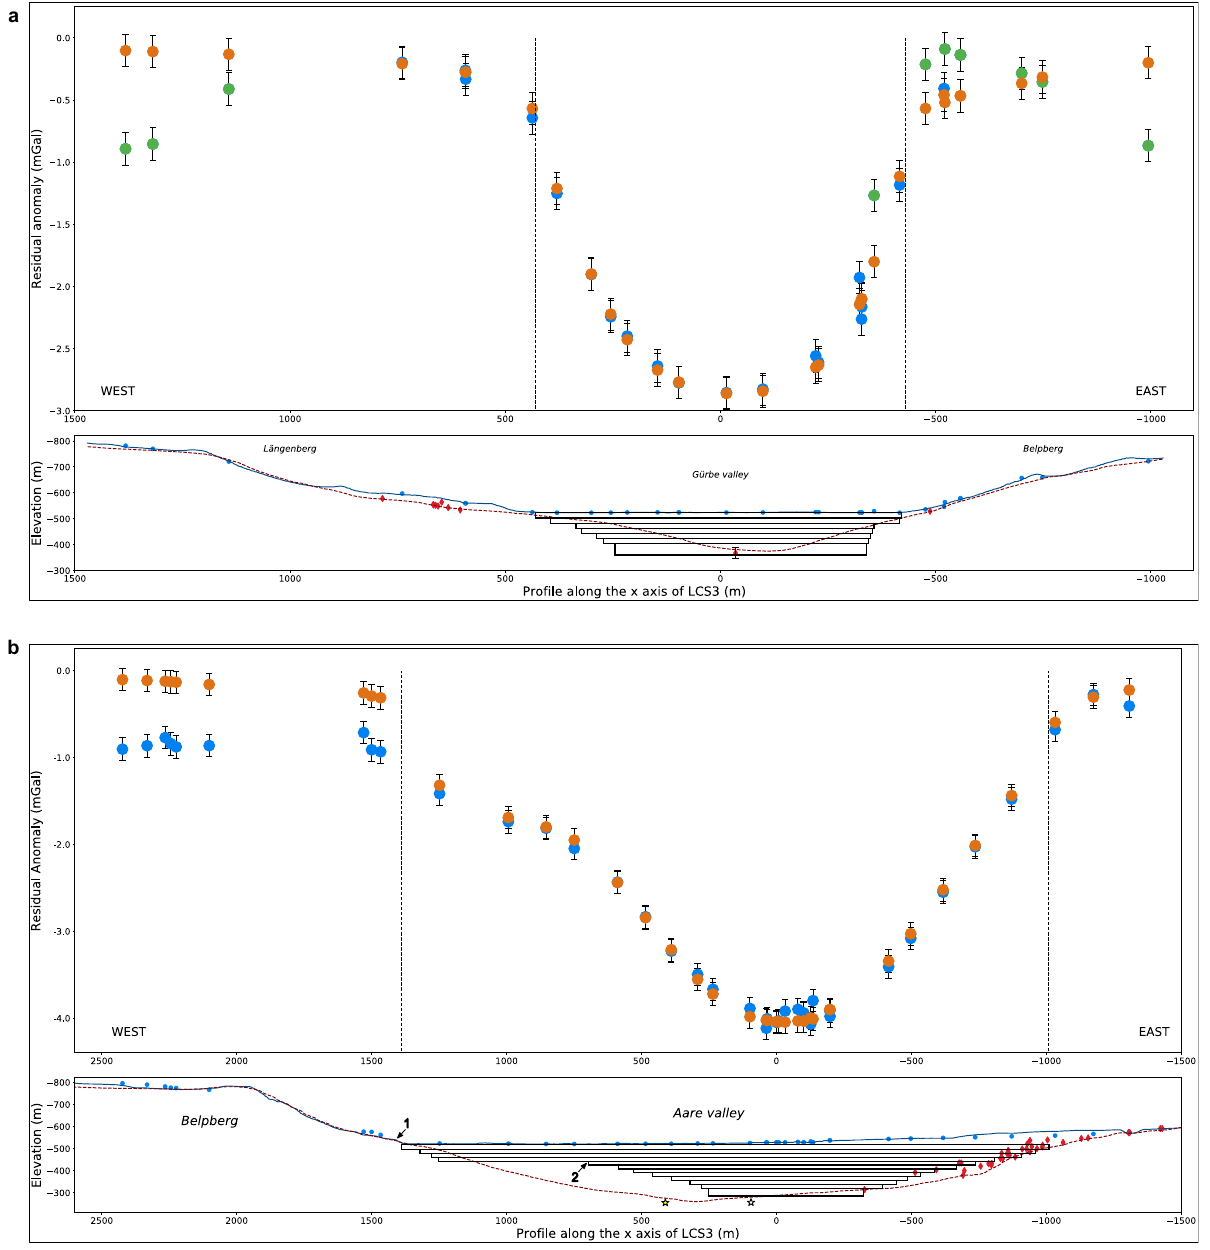
Figure 5. Results of gravity modelling. ( a ) Top: Final modelled residual anomaly, shown by the orange dots. Bottom: Plot of the final geometry of the Gürbe valley. This model suggests that the Gürbe valley is underlain by an overdeepening with an asymmetrical, U-shaped geometry. At our section, we estimate a maximum depth of c. 160 m. The eastern valley flank displays a knickzone at c. 40 m depth, which corresponds to the elevation where an LGM till has been encountered in the drilling RB9201 (Fig. 6b). ( b ) Similar plot for the Aare valley overdeepening, characterized by a maximum depth of c. 235 m. The western flank indicates the presence of two steps marked by the numbers 1 and 2 in the Figure. On the eastern margin, the bedrock flanks dips at c. 20°. The valley bottom has approximately the same cross-sectional width as the Gürbe overdeepening. Note that the drillings on the eastern margin imply a complex geometry as the bedrock depths vary along the overdeepening’s flank, and the overdeepening is turning counterclockwise, which complicates the modelling. Therefore, we proceeded through yielding a best fit between modelling results and drilling information through trial and error. Please refer to Fig. 4b,c for the legend and the explanation of the colours. Note, however, that the orange dots represent the modelled residual anomaly. Please refer to Fig. S2 for estimates of the density of the Molasse bedrock, and the supplementary note S4 for the determination of the density contrast between the Quaternary deposits and the Molasse bedrock. Intermediate modelling steps for assessing the bedrock geometry underneath the Gürbe and Aare valleys are illustrated and discussed in the supplementary notes S5 for the Gürbe valley, and S6, S7 for the Aare valley. The inputs and outputs of the final models, of both valleys, are available in the supplementary dataset